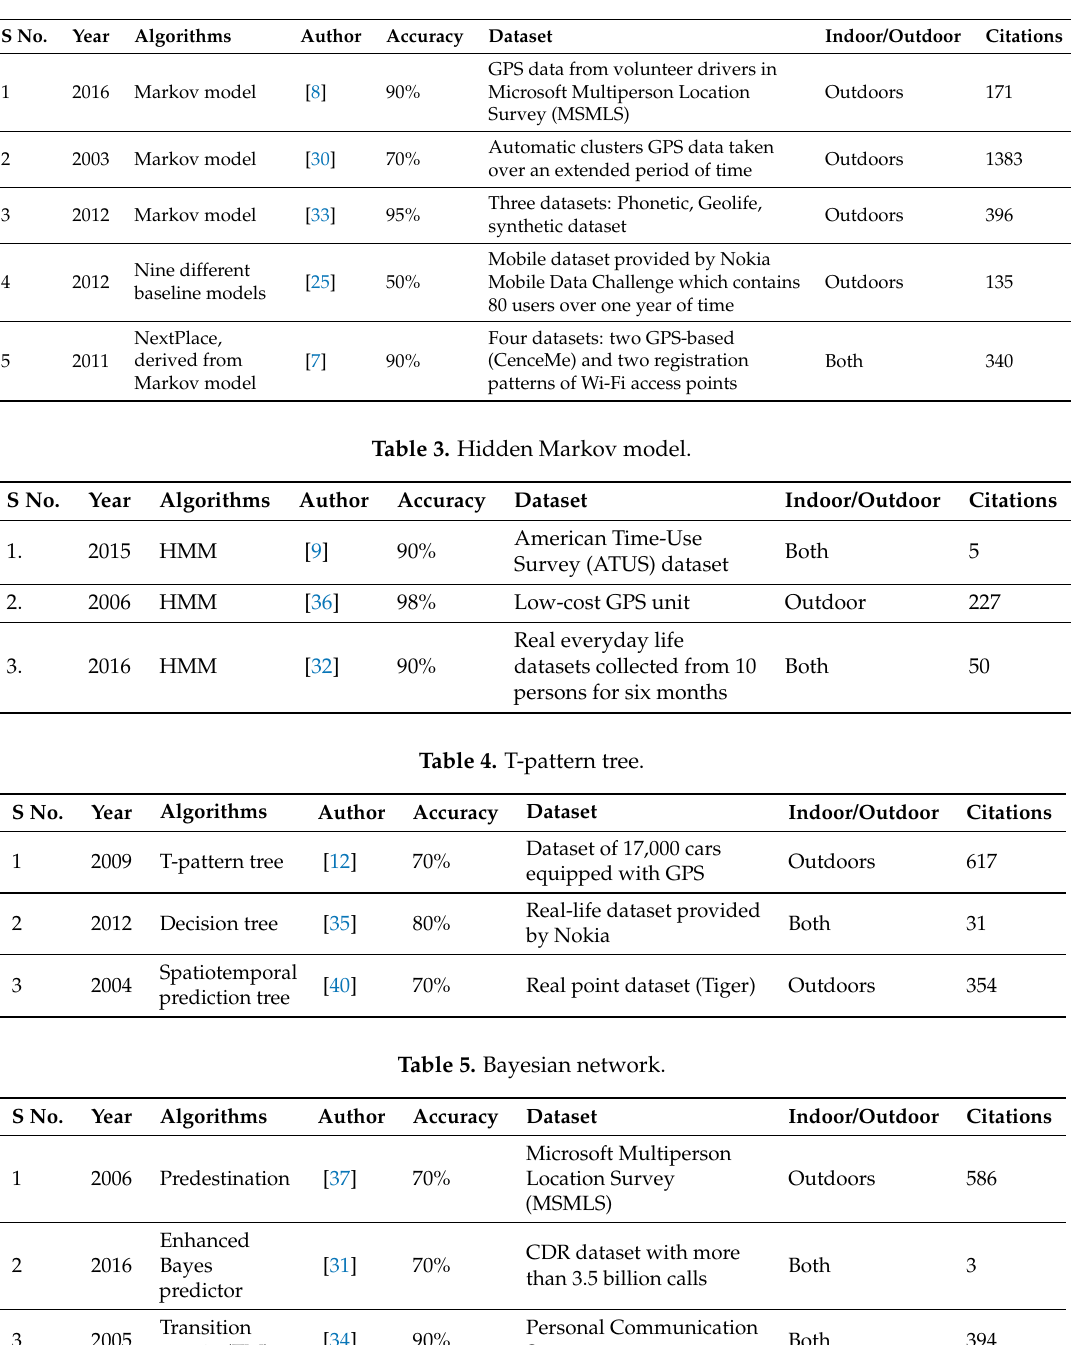
Table 2. Markov model.